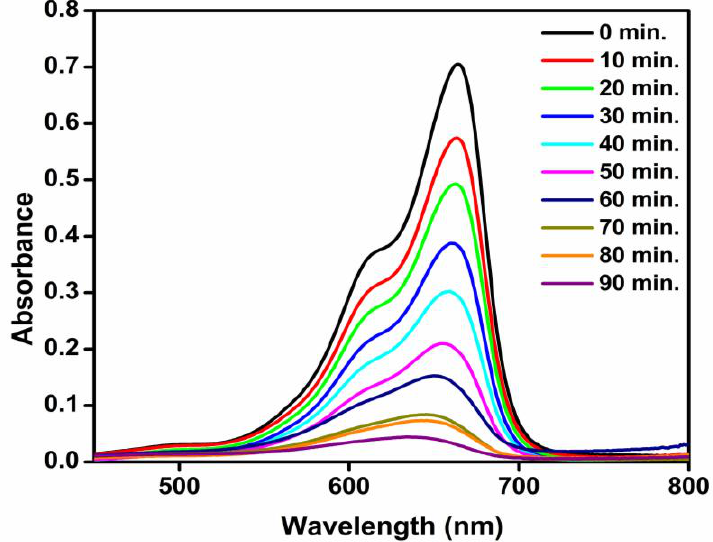
Figure 12. UV-visible spectra of methylene blue (MB) over various time intervals, in the presence of TiO 2 nanocatalysts.